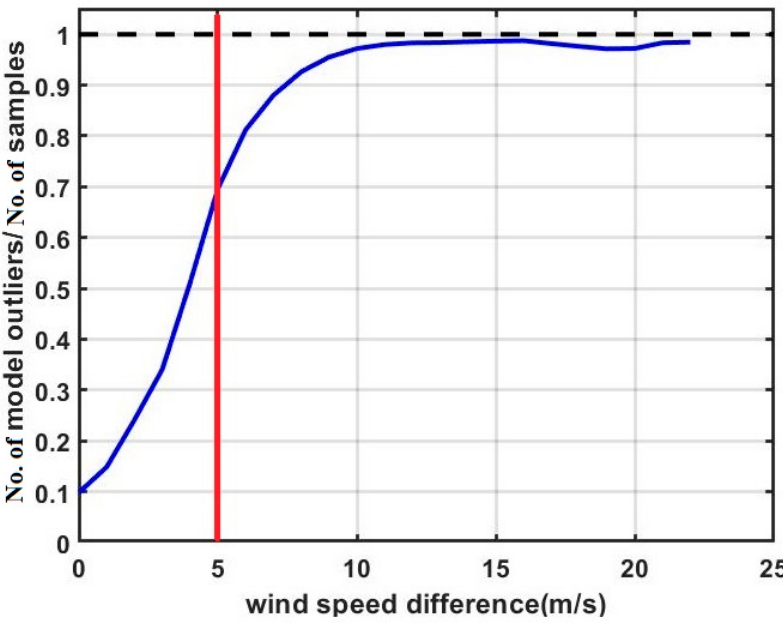
Figure 8. Ratio of outliers rightly identified by the filter to the actual no. of outliers vs. wind speed difference.